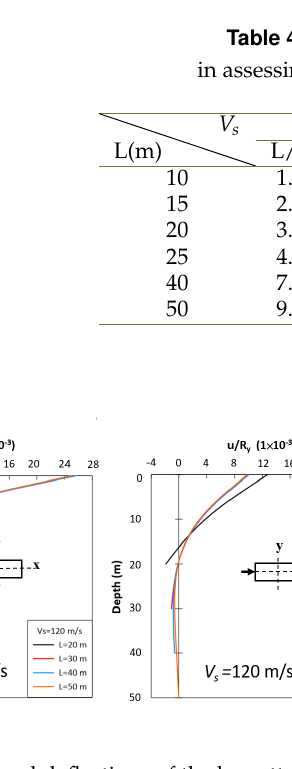
Fig. 13. Normalized deflections of the barrette in clays ( v s =120m/s)